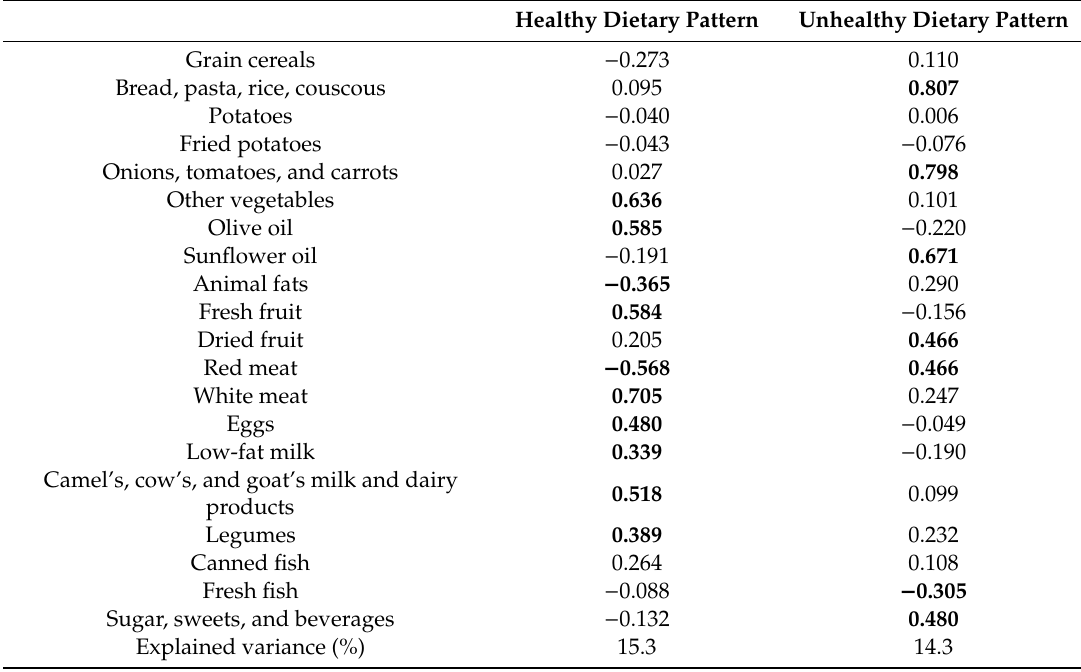
Table 3. Score coe ffi cients derived from principal component analysis regarding foods or food groups consumed by Saharawi diabetic women.